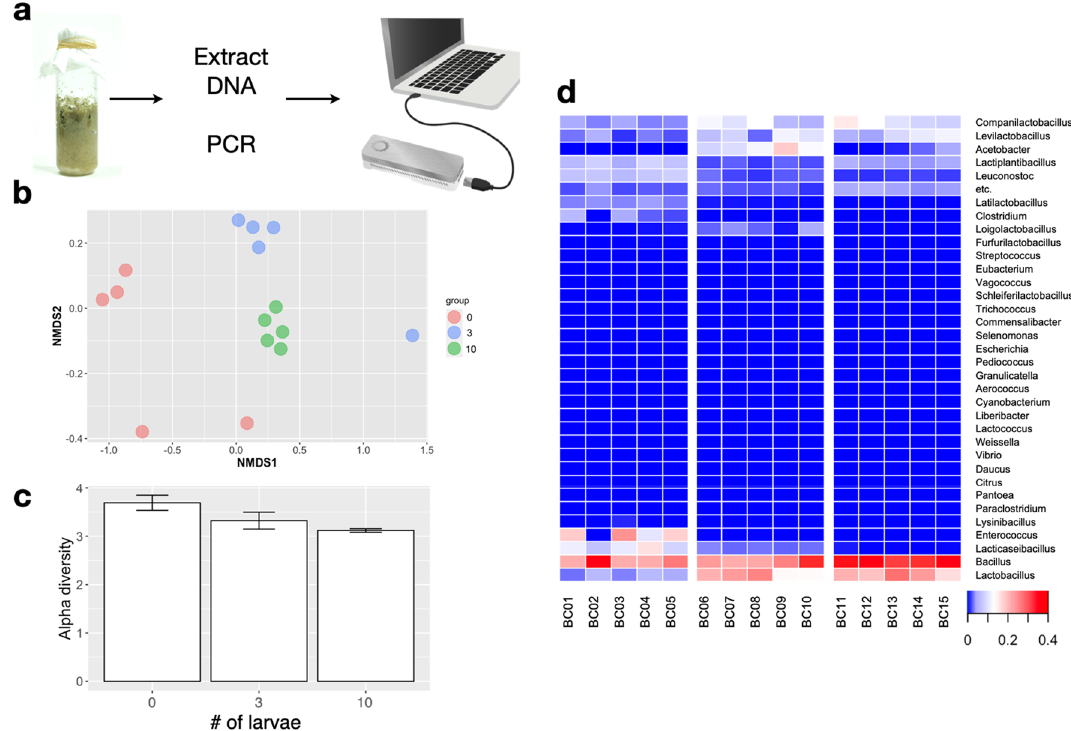
Figure 4. Overview of metagenomic analysis of microbes present in food waste. ( a ) Schematic diagram of the methods for metagenomic analysis. ( b ) Non-metric multidimensional scaling (NMDS) analysis of species detected by 16 s amplicon sequencing. ( c ) Comparison of alpha diversity (Shannon Index) of species detected in each treatment. ( d ) Heatmap analysis of genera detected in each treatment (no-larvae: BC01–BC05,